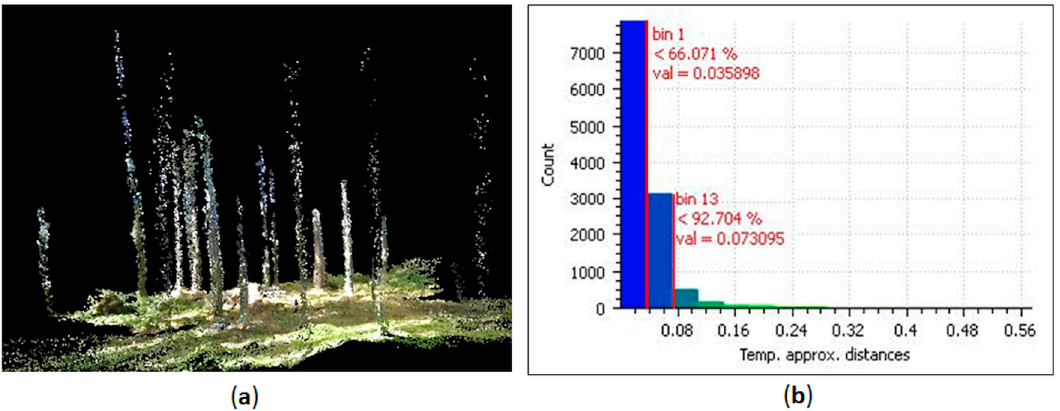
Figure 7. Accuracy assessment of object reconstruction: ( a ) Personal Mobile Terrestrial System point cloud after tree leaf filtering; and ( b ) histogram of the estimated errors in tree positions.